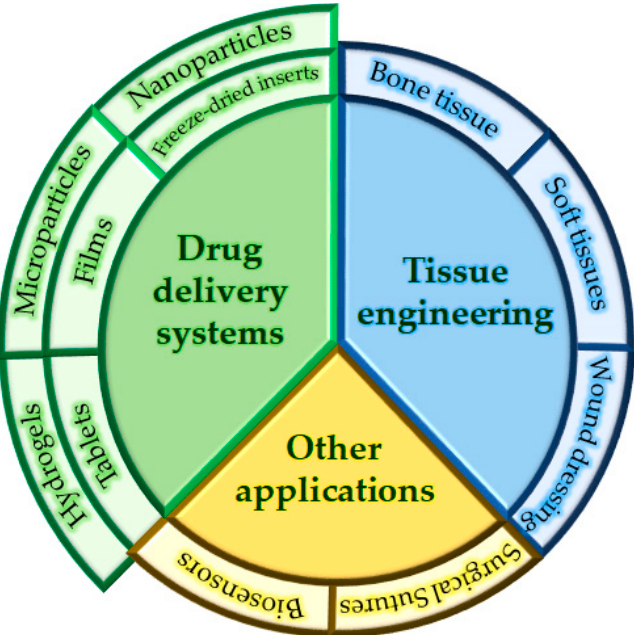
Figure 11. Diagram of the main applications found in the literature for PECs.